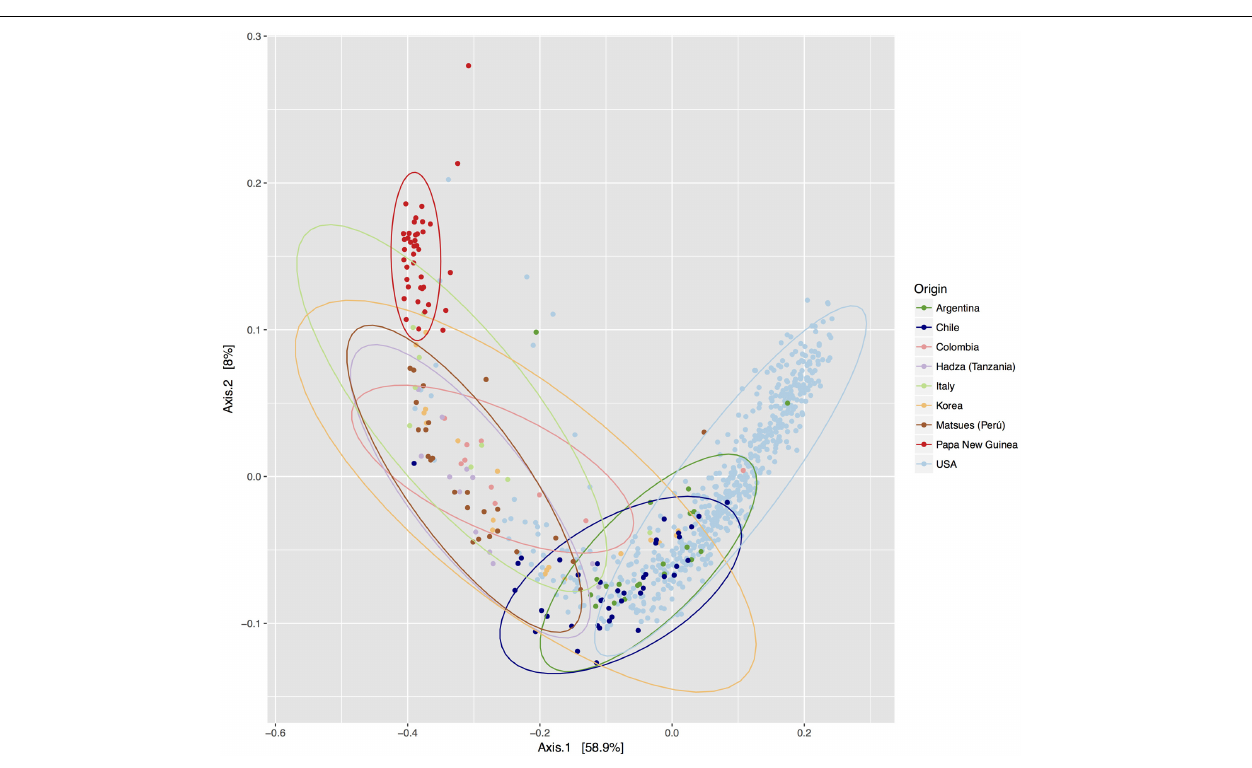
FIGURE 2 | Comparison of the Chilean gut microbiota versus gut microbiota of individuals from other geographic locations. PCoA of the beta diversity values based on weighted Unifrac distances. Each color represents a population from a specific geographic area. Ellipses were drawn using a confidence interval of 95% for each